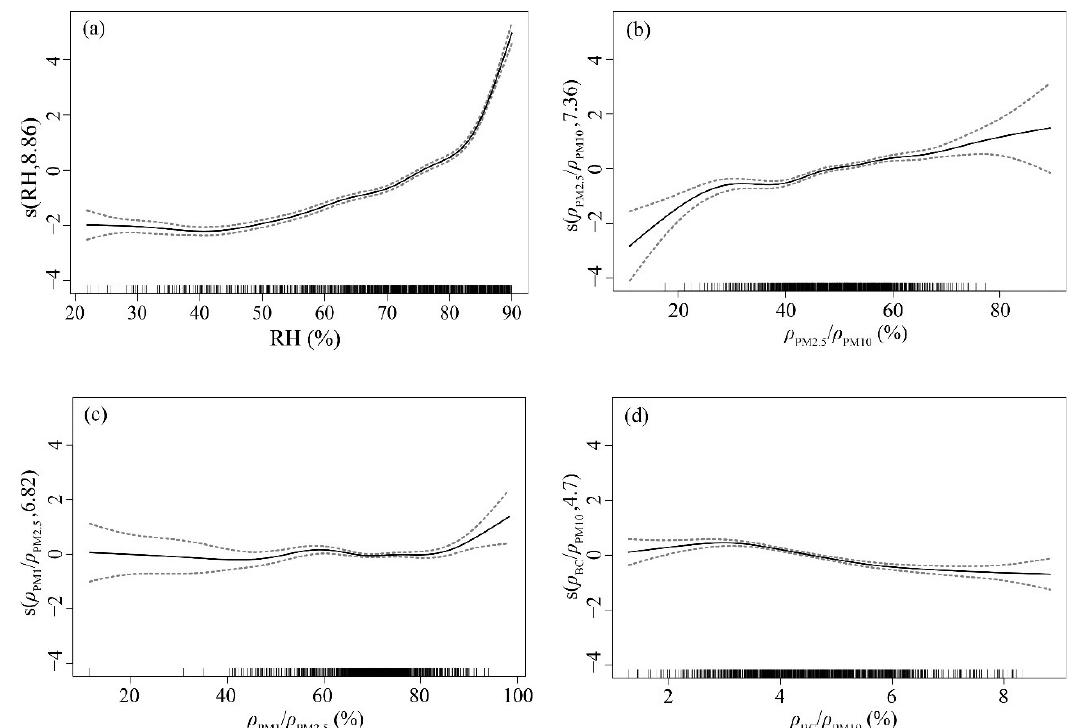
Figure 6. Effect of the environmental meteorological factors on the change of the aerosol extinction coefficient per unit of mass. ( a – d ) represent the effect of RH, ρ BC / ρ PM10 , ρ PM1 / ρ PM2.5 and ρ PM2.5 / ρ PM10 , respectively.